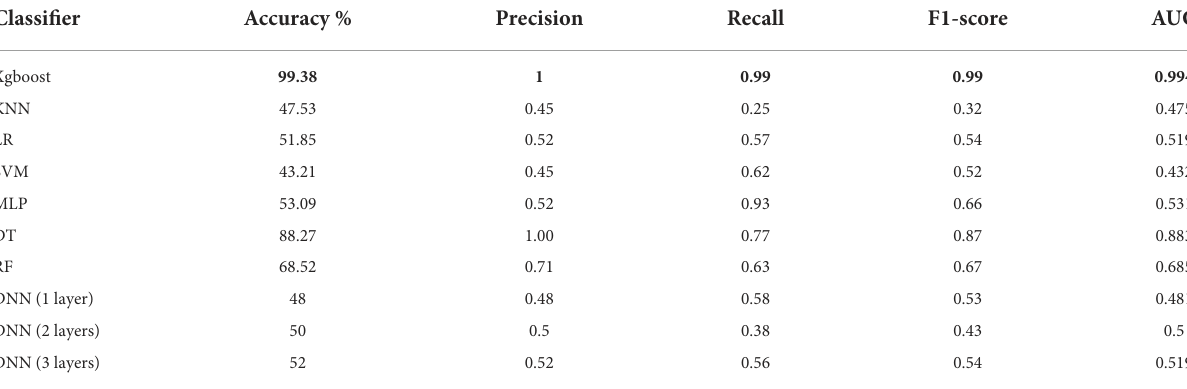
TABLE 4 The performance of all Ml models and DNN for detection of DR using a combination of VGG-16 and retinal lesion features. Classifier Accuracy %